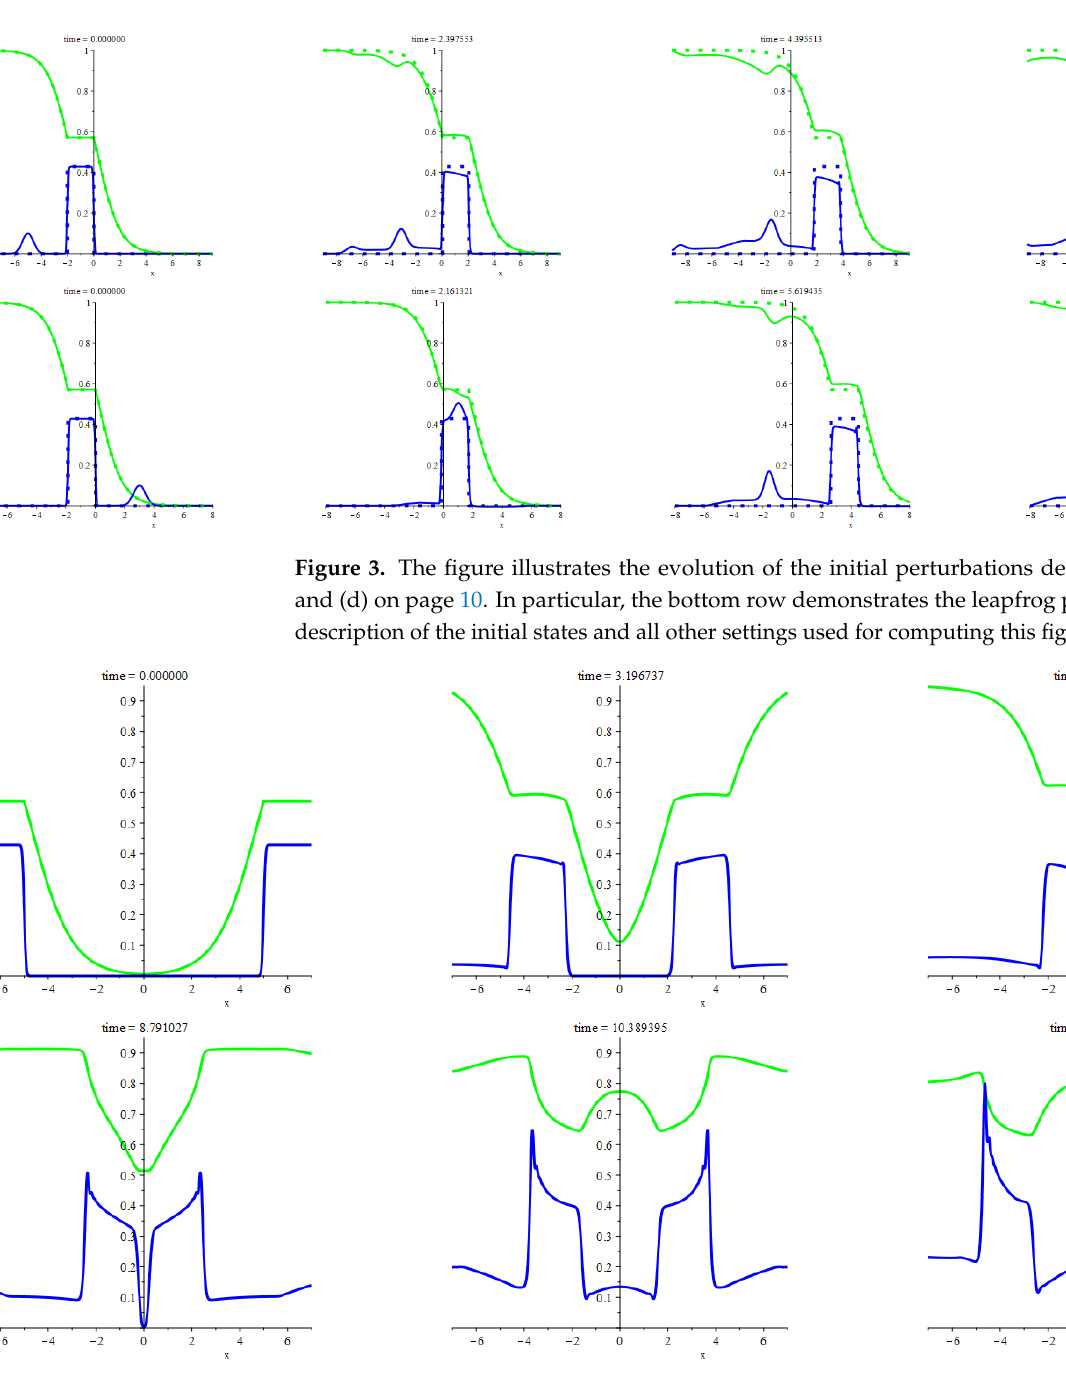
Figure 4. The figure illustrates a collision of two patchy waves, which propagate at the opposite speeds. The blue (green) lines are for the instant profiles of the predators’ (prey) density. The detailed description of the initial states and other settings used for computing this figure is in Appendix